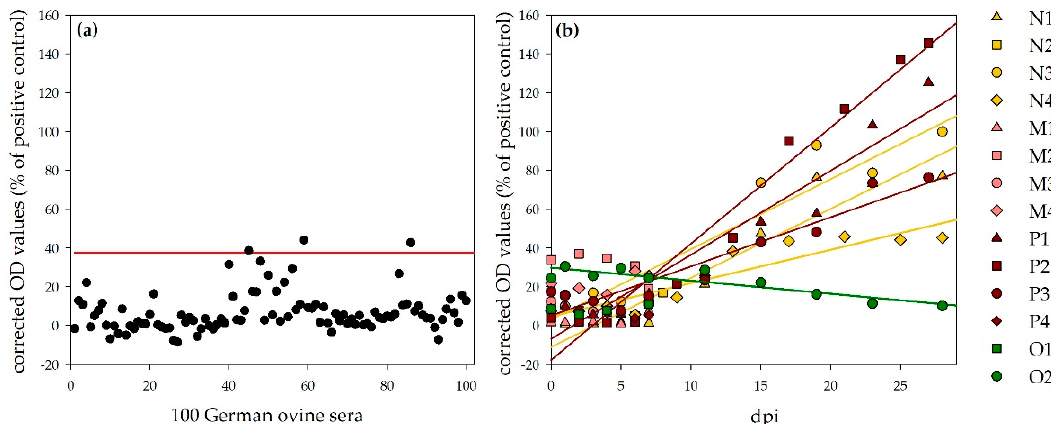
Figure 6. NSDV ELISA results for ovines: Panel ( a ) shows the results for 100 German ovine reference sera for the determination of the negative cut-off (illustrated by the red line; specificity, 97%). Panel ( b ) shows the results for the challenged sheep. Whereas the OD values for the control sheep (O2) stayed on the same level, linear regressions (calculation performed by Sigmaplot) show a steady increase in OD values for the infected sheep, which survived until the end of the observation period.